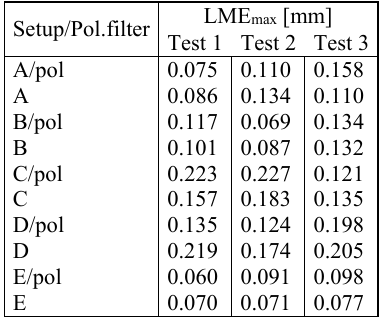
Table 1. Resulting LME max for camera setups.